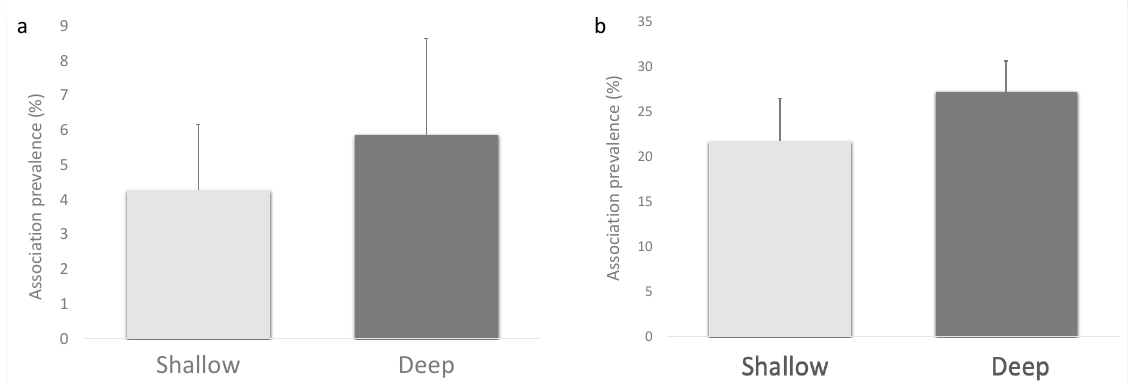
Figure 3. Prevalence of Nemalecium lighti – sponges association in the study area: ( a ) Mean association prevalence for all the genera considered and ( b ) for the genus Aplysina in relation to depth.